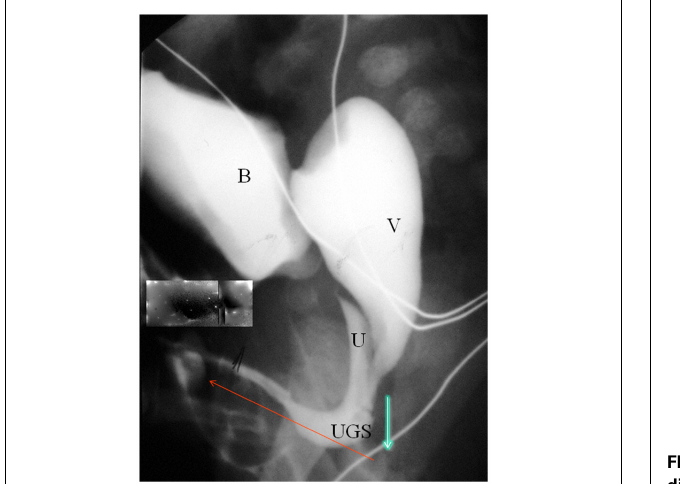
FIGURE 1 | Contrast study in patient with typical anatomy in a Prader 3–5 CAH . B, bladder; U, urethra;V, vagina.The blue arrow indicates the distance between the confluence and the perineal skin.The red arrow indicates the length of the UGS which is not relevant to the difficulty of the mobilization.The excess tissue can be used to create a mucosa lining of the vestibule during vulvoplasty. (6). Because of this, we no longer restrictTUM to UGS less than 3cm in length.